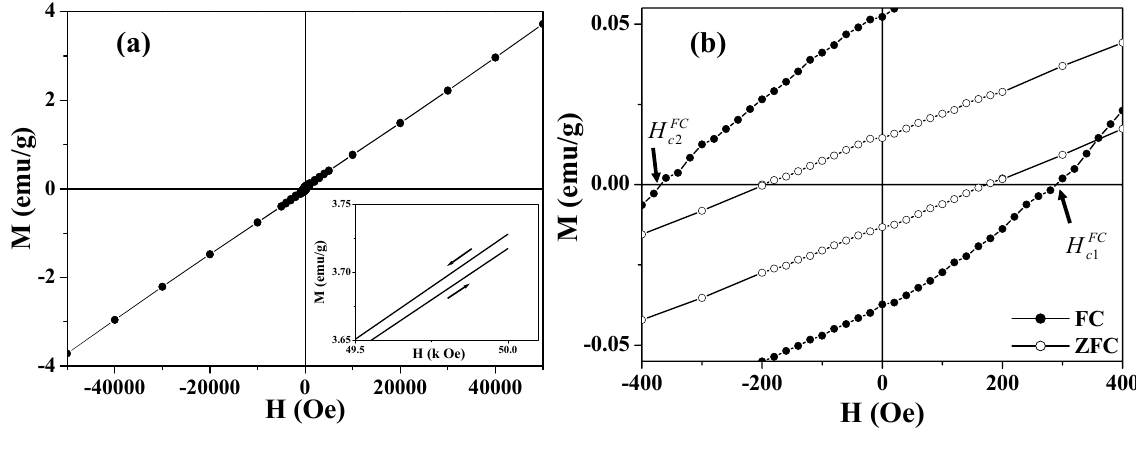
Figure 6. Hysteresis loops of 360 nm Co measured at 2 K; the inset shows the high field irreversibility of magnetization; (b) The central part of the ZFC (open circle) and FC (solid circle) hysteresis loops measured at 2